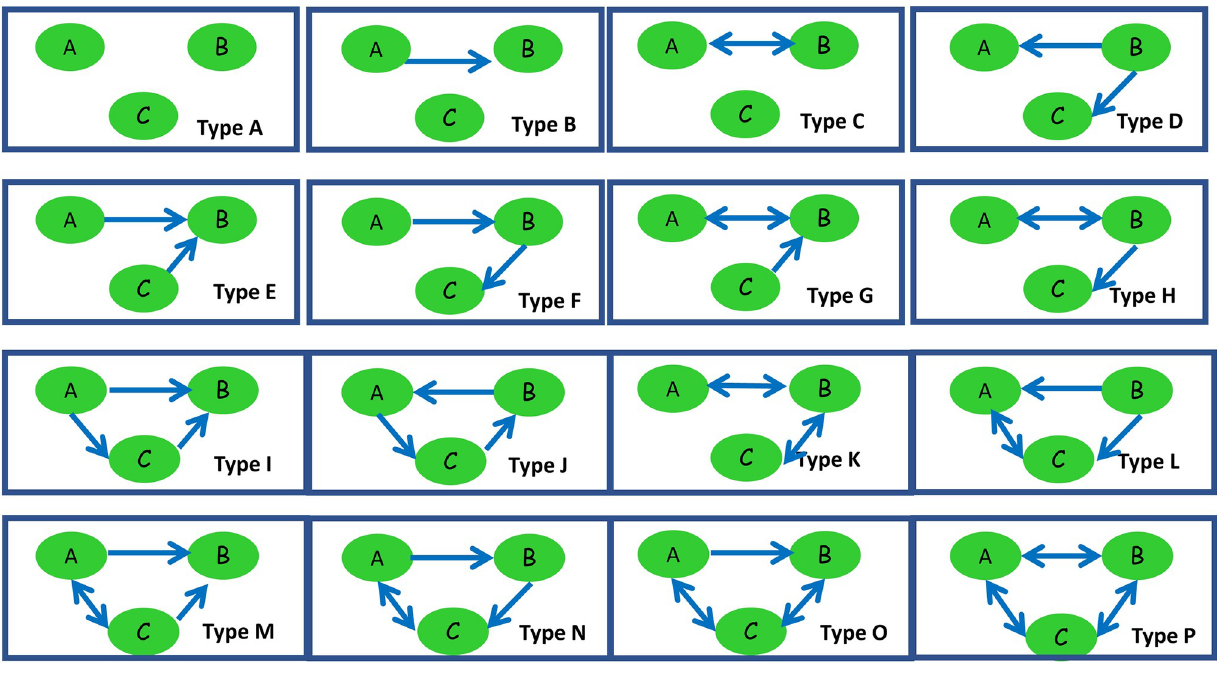
Fig 12. Value chart of F ( k ) according to k .